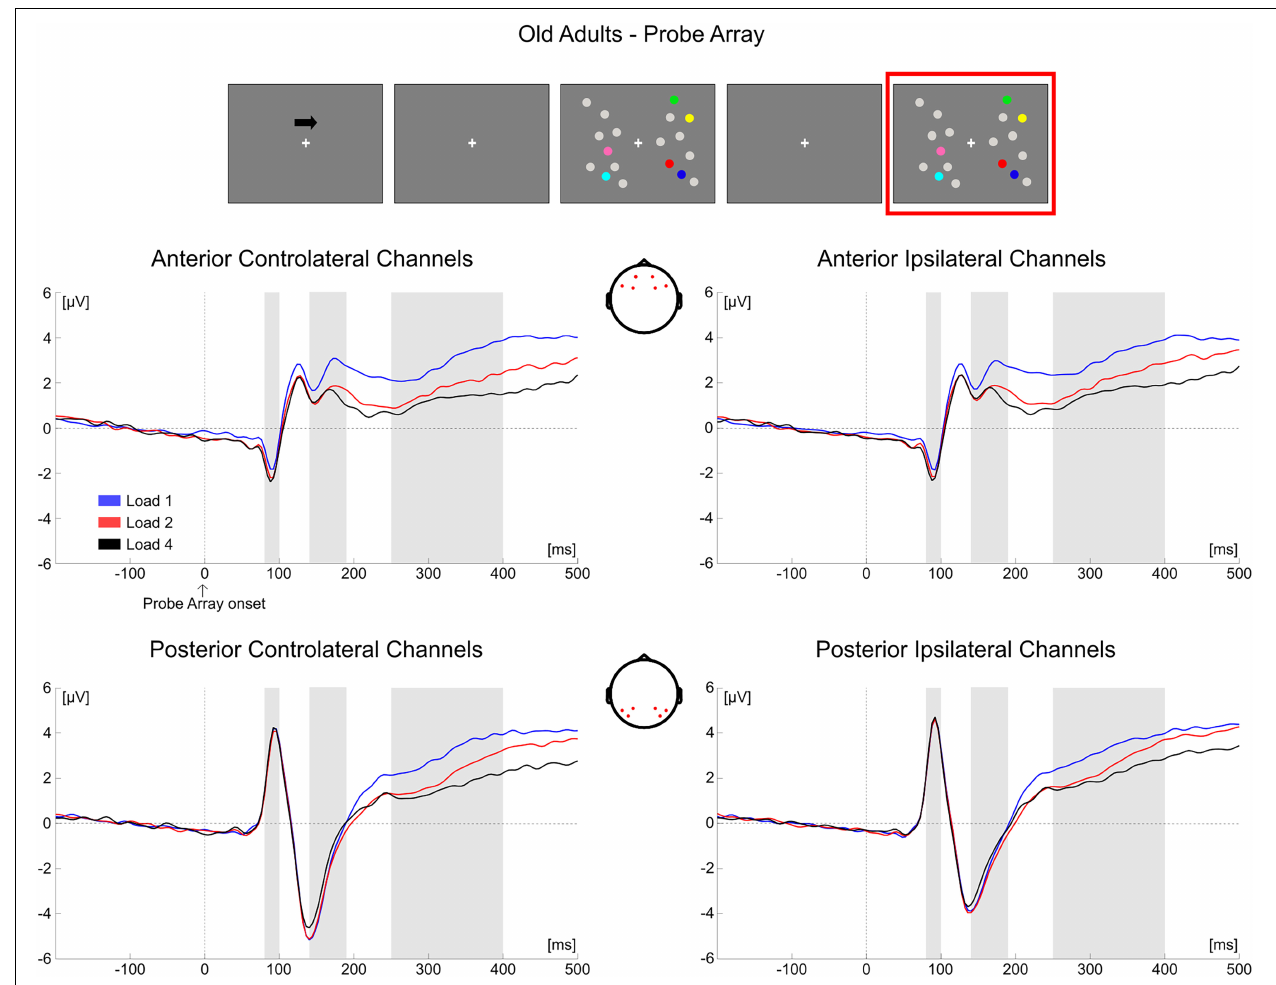
FIGURE 11 | Grand average waveforms as a function of target load over the anterior (Fp1/2, F3/4, F7/8) and posterior ROI (P7/8, PO7/8, P3/4), separately for contra- and ipsilateral to target channels, in the Older group during item comparison. Topographies highlight the channels included in the ROIs and gray squares indicate the TOIs over which the mean amplitudes were